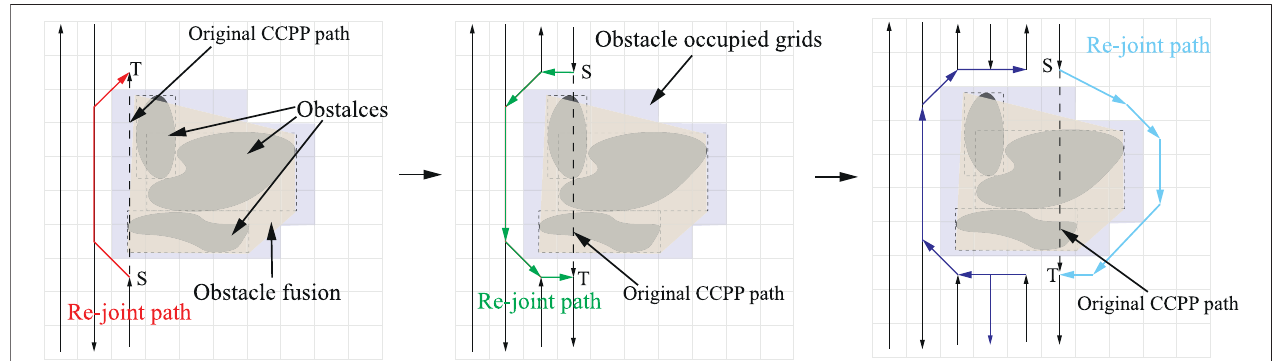
FIGURE 6 | The illustration of the path re-joint